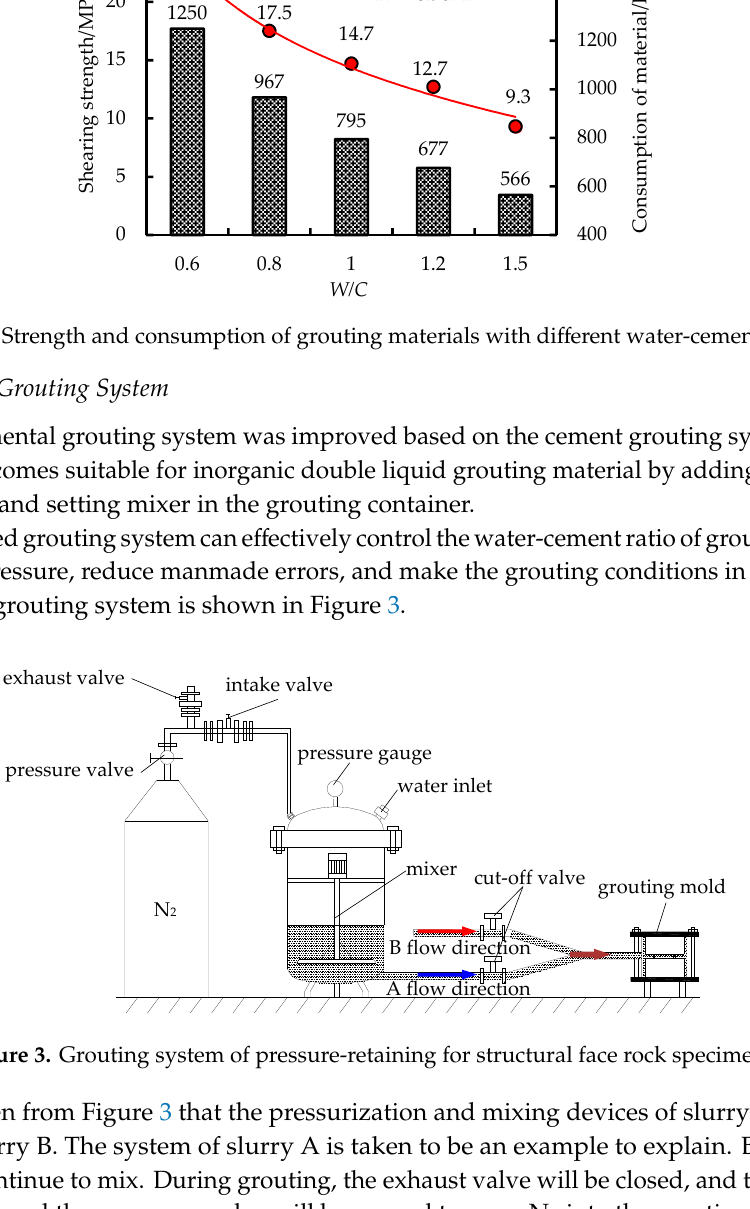
Figure 2. Strength and consumption of grouting materials with different water-cement ratios.